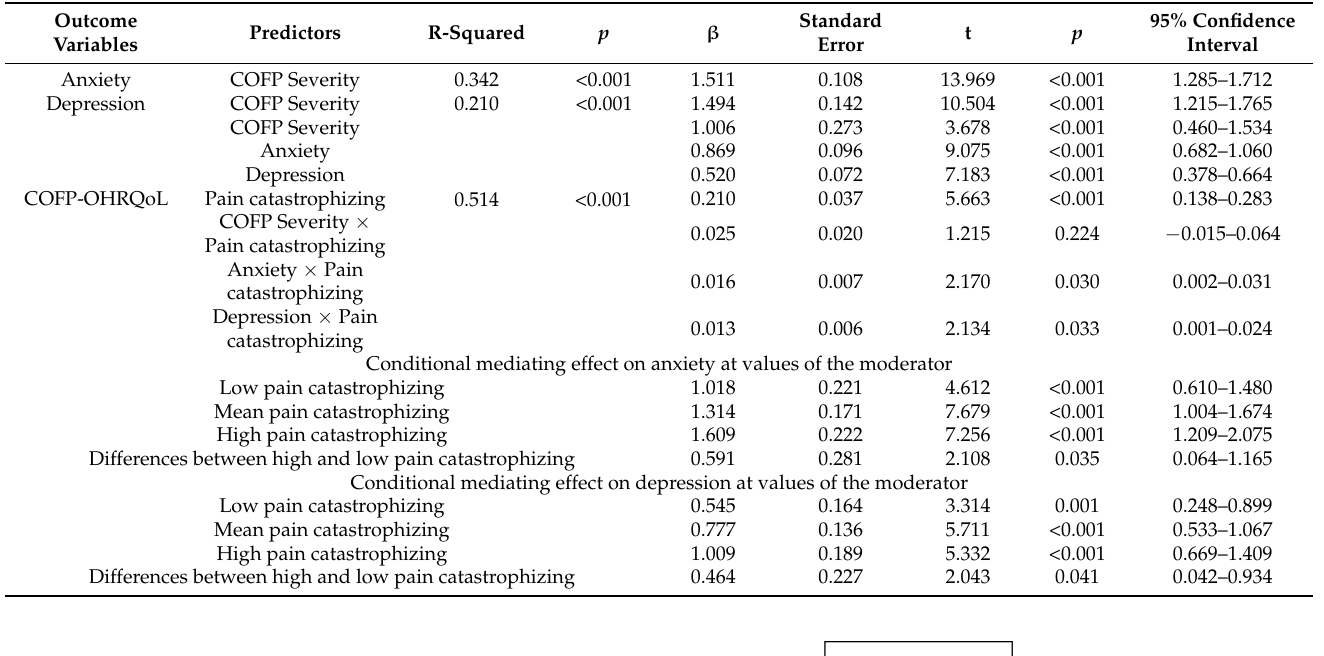
Table 3. Results regarding the mediation effect of anxiety and depression.